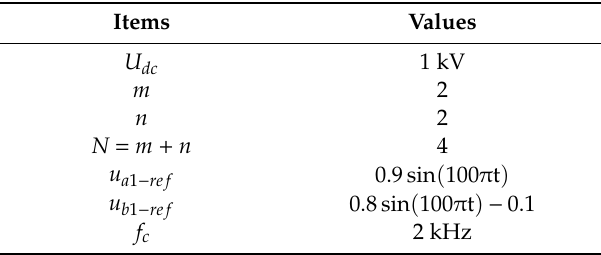
Table 2. Simulation